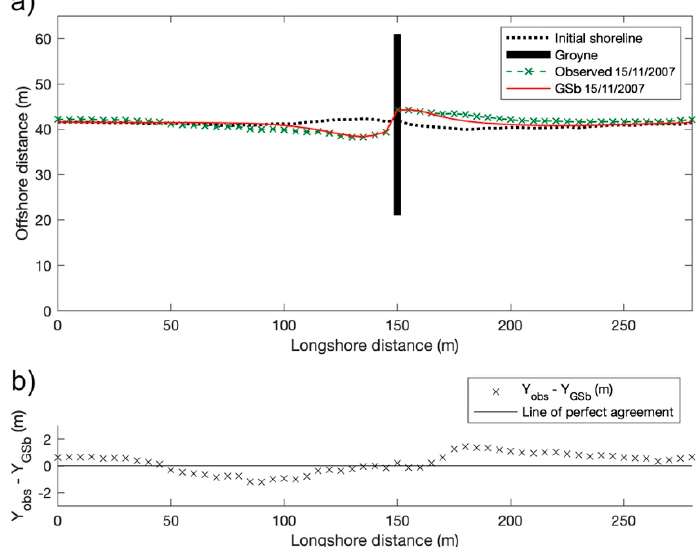
Figure 18. ( a ) Observed and calculated shorelines after 45 days from the groyne deployment. ( b ) Difference Y obs –Y GSb .